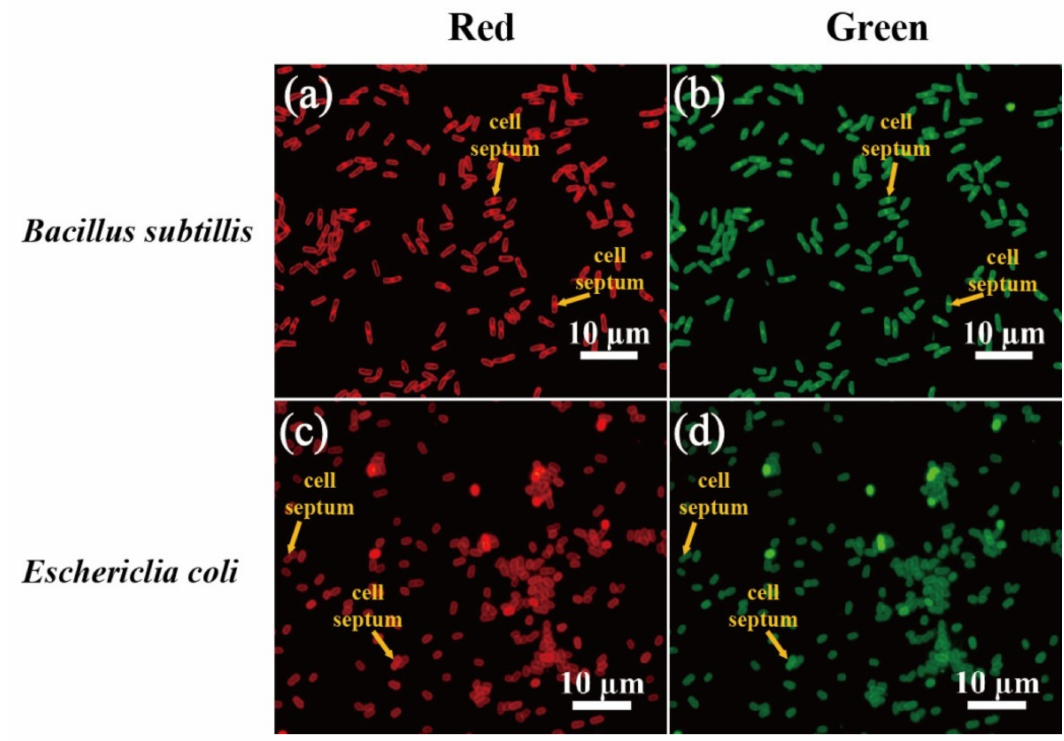
Figure 6. Fluorescence microscopy images of B. subtilis and E. coli cells stained with 1000 ppm N-CQDs. Red fluorescence ( a , c ) were detected under TRITC filter set, whereas green fluorescence ( b , d ) were detected under FITC filter set. Scale bar represents 10 µ m. Yellow arrow indicates cell septum.